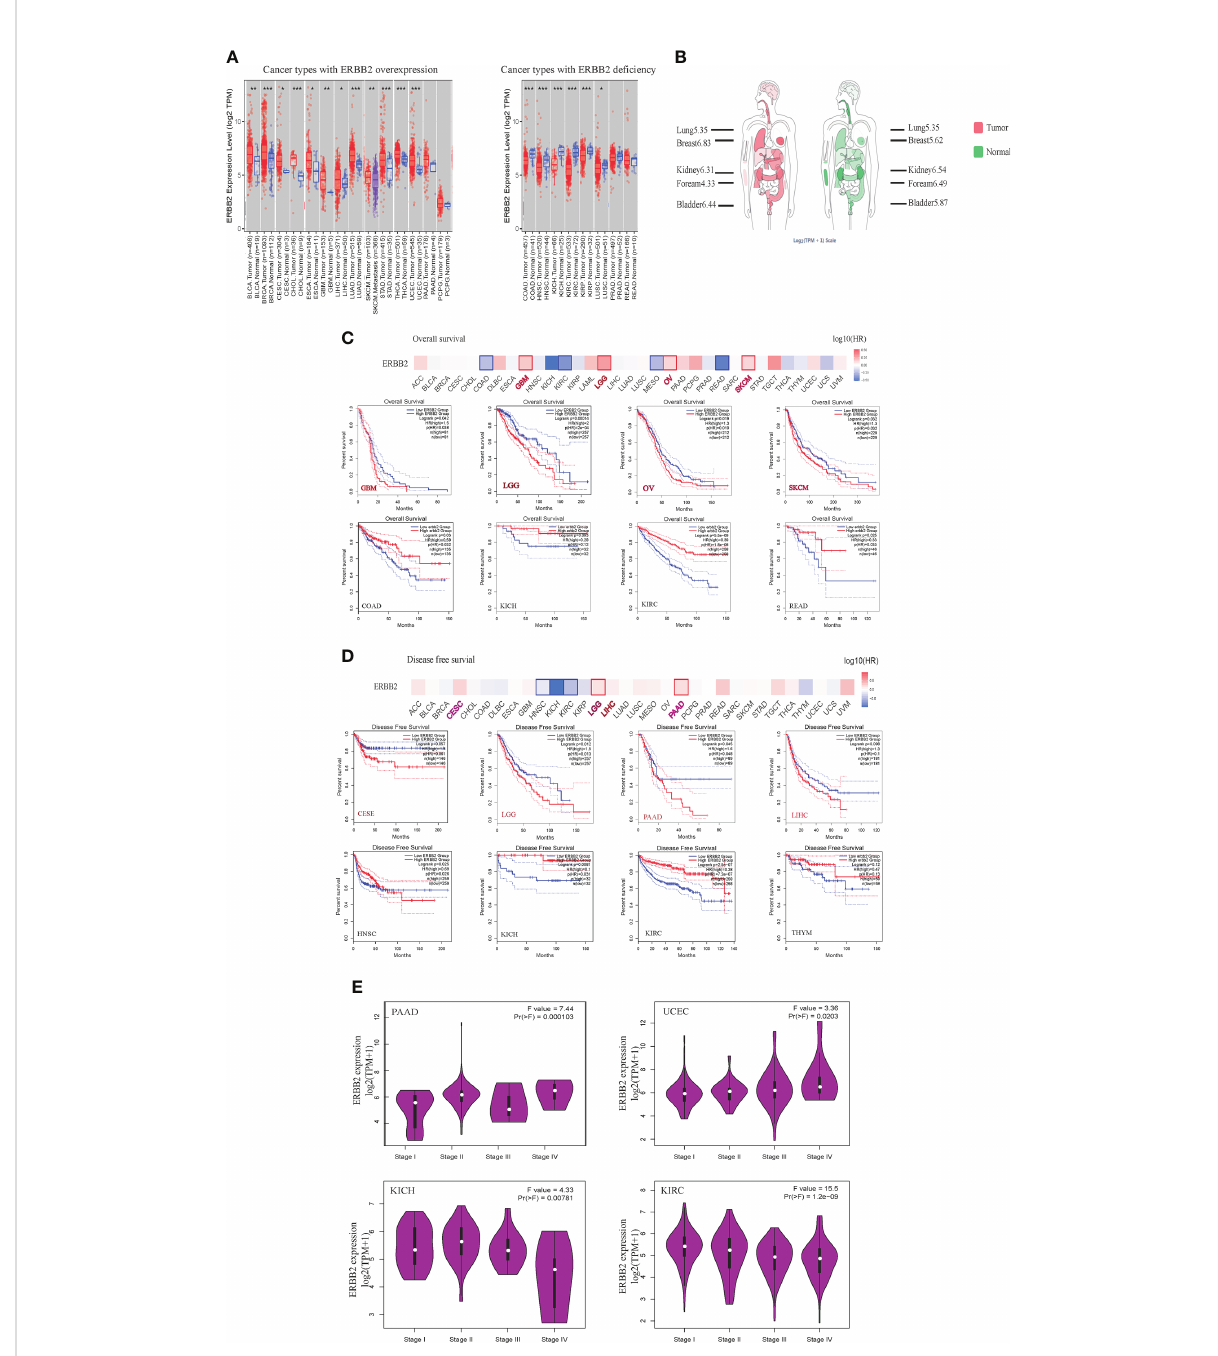
FIGURE 1 The expression of ERBB2 gene in pan-cancers. (A) Distributions of gene expression levels are displayed using box plots. The statistical value analyzed using the Wilcoxon test is annotated by the number of stars (*p-value < 0.05; **p-value <0.01; ***p-value <0.001). (B) The distribution graph of the ERBB2 gene in human tissues. The median expression of ERBB2 in tumor and normal samples shows in the body map. Log2 (TPM +1) index marked in different tissues. A larger value shows higher level of ERBB2 gene expression. Overall survival (C) and disease-free survival (D) analyses of different tumors of the TCGA database using Kaplan-Meier curves. The survival map and Kaplan-Meier curves with positive results draw with the red or blue line. (E) Based on the TCGA database, the expression of the ERBB2 gene is present with pathological stages (stage I, stage II, stage III, and stage IV) of PAAD, UCEC, KICH, and KIRC. Log2 (TPM+1) applied for